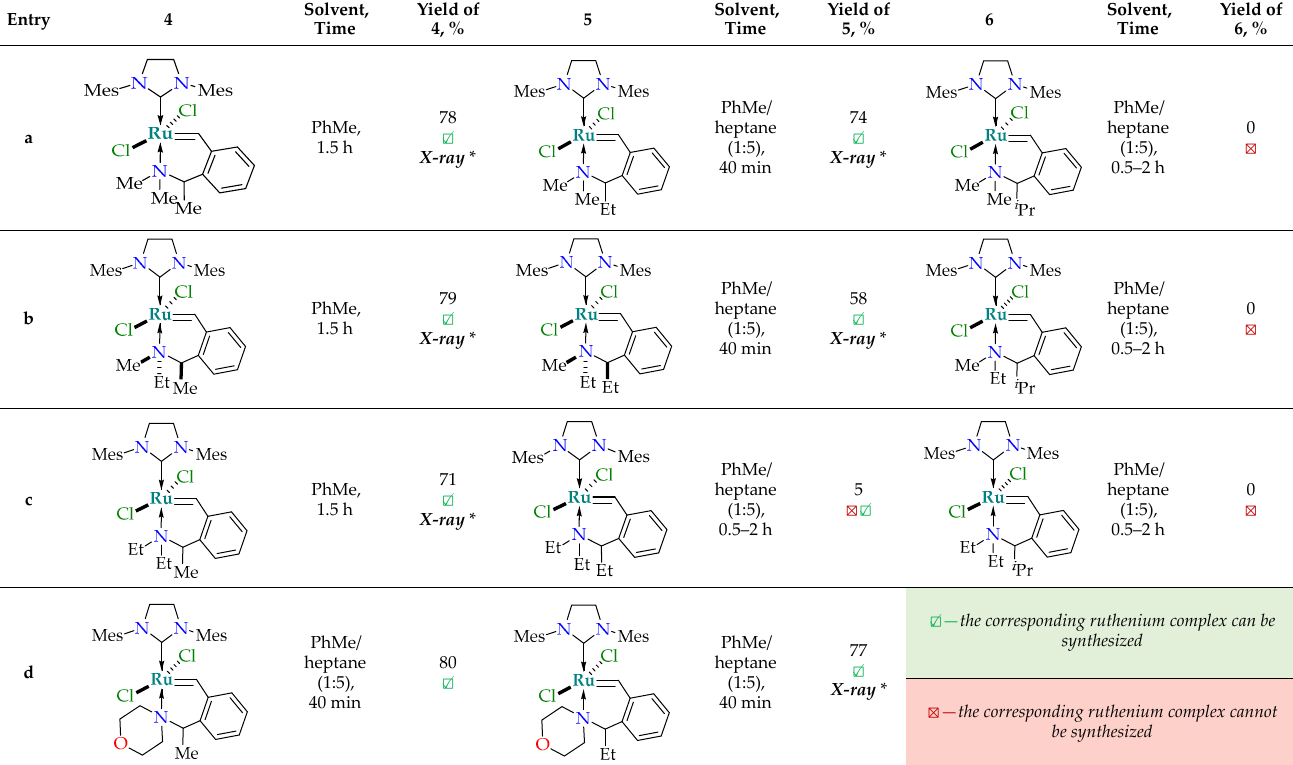
Table 2. Structures and yields of ruthenium complexes 4a – d , 5a – d .